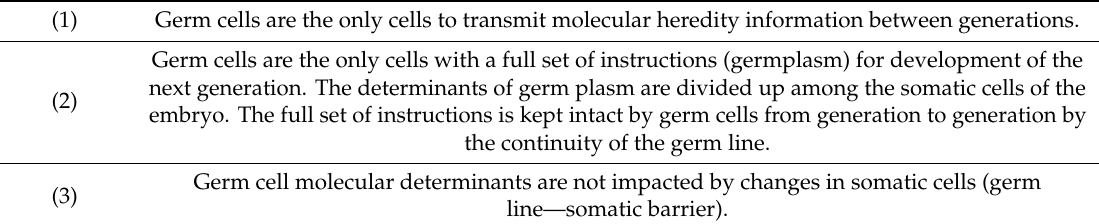
Table 1. Weismann’s Germ Plasm Theory